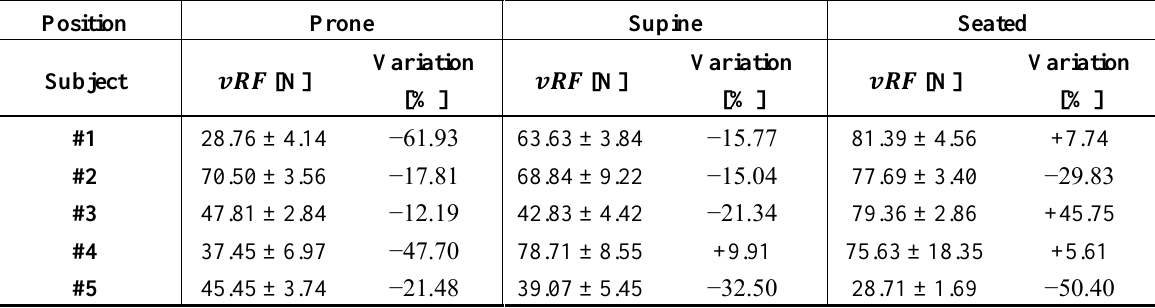
( e ) Table 4. Vertical reaction force ( ): for each subject and posture the average value and standard deviation of (µ ± σ) along with the percentage of variation with respect to the body weight are